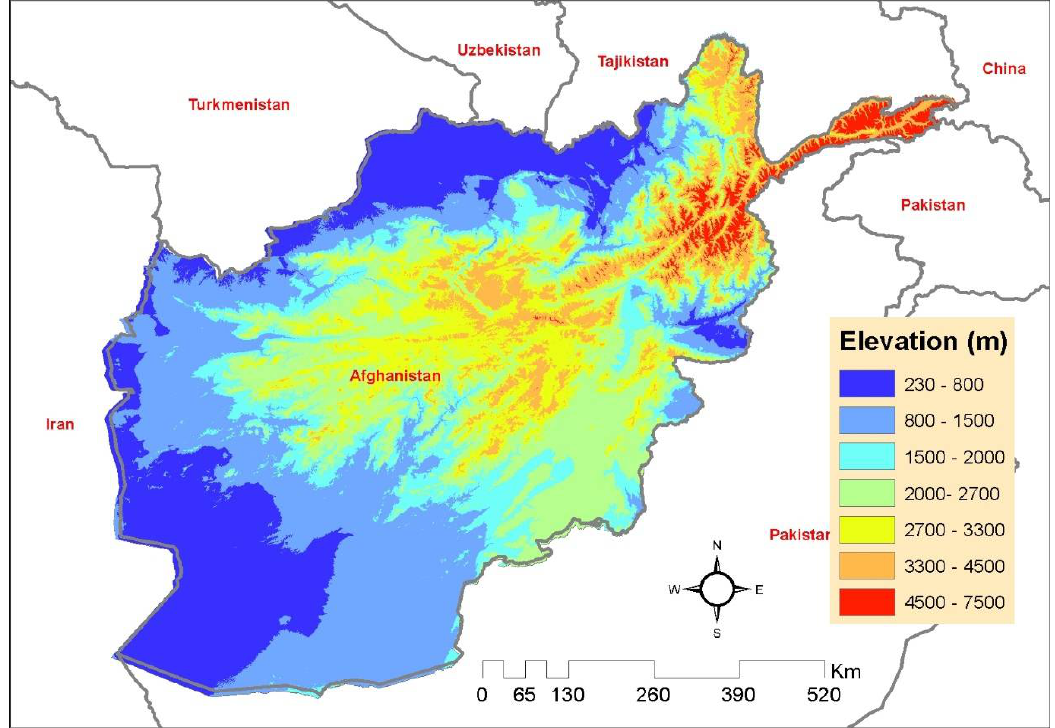
Figure 1. The map of Afghanistan, including an elevation profile. Table 1. Remote sensing data used in this